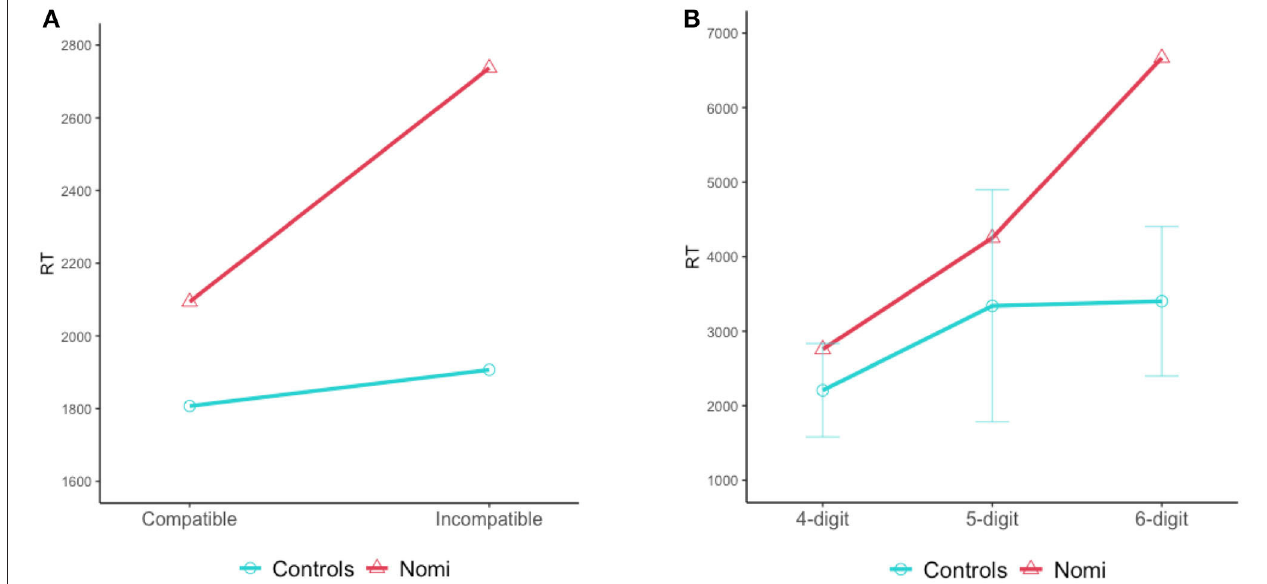
FIGURE 6 | Number-comparison task: Mean RTs of Nomi and the control group. (A) RTs in the different-length pairs in the compatible condition (in which the longer number also had a larger first-digit) and in the incompatible condition (in which the longer number had a smaller first-digit). (B) RTs in the same-length pairs with similar first-digit, of 4-, 5-, and 6-digit